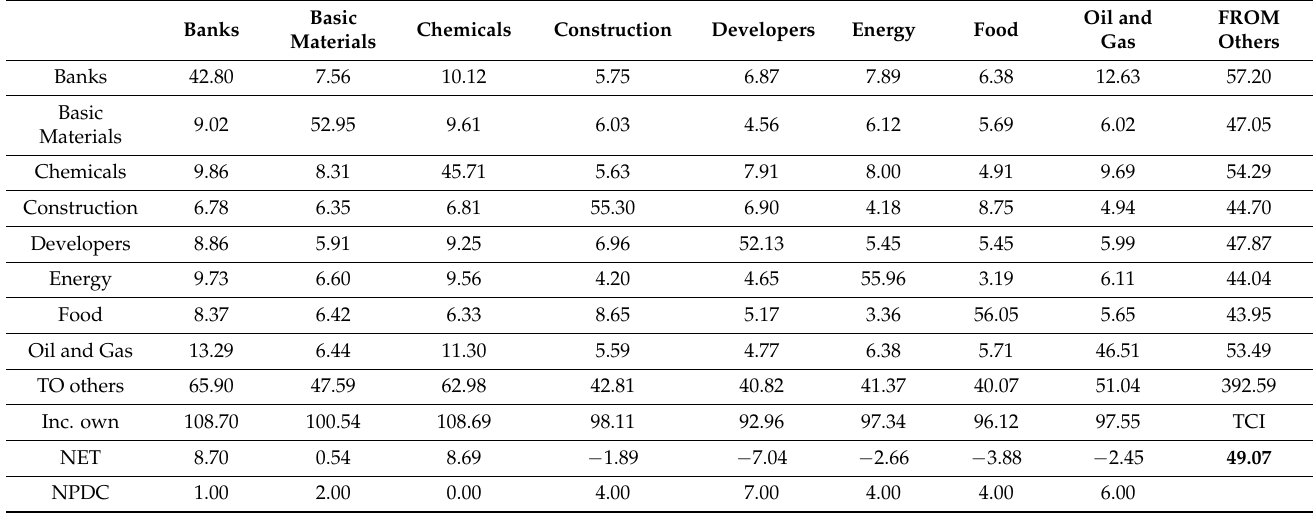
Table 6. Total volatility spillover for the period of 1 January 2020–2 December 2021.